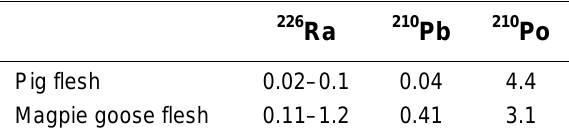
Radionuclide Activity Concentrations (Bq/kg